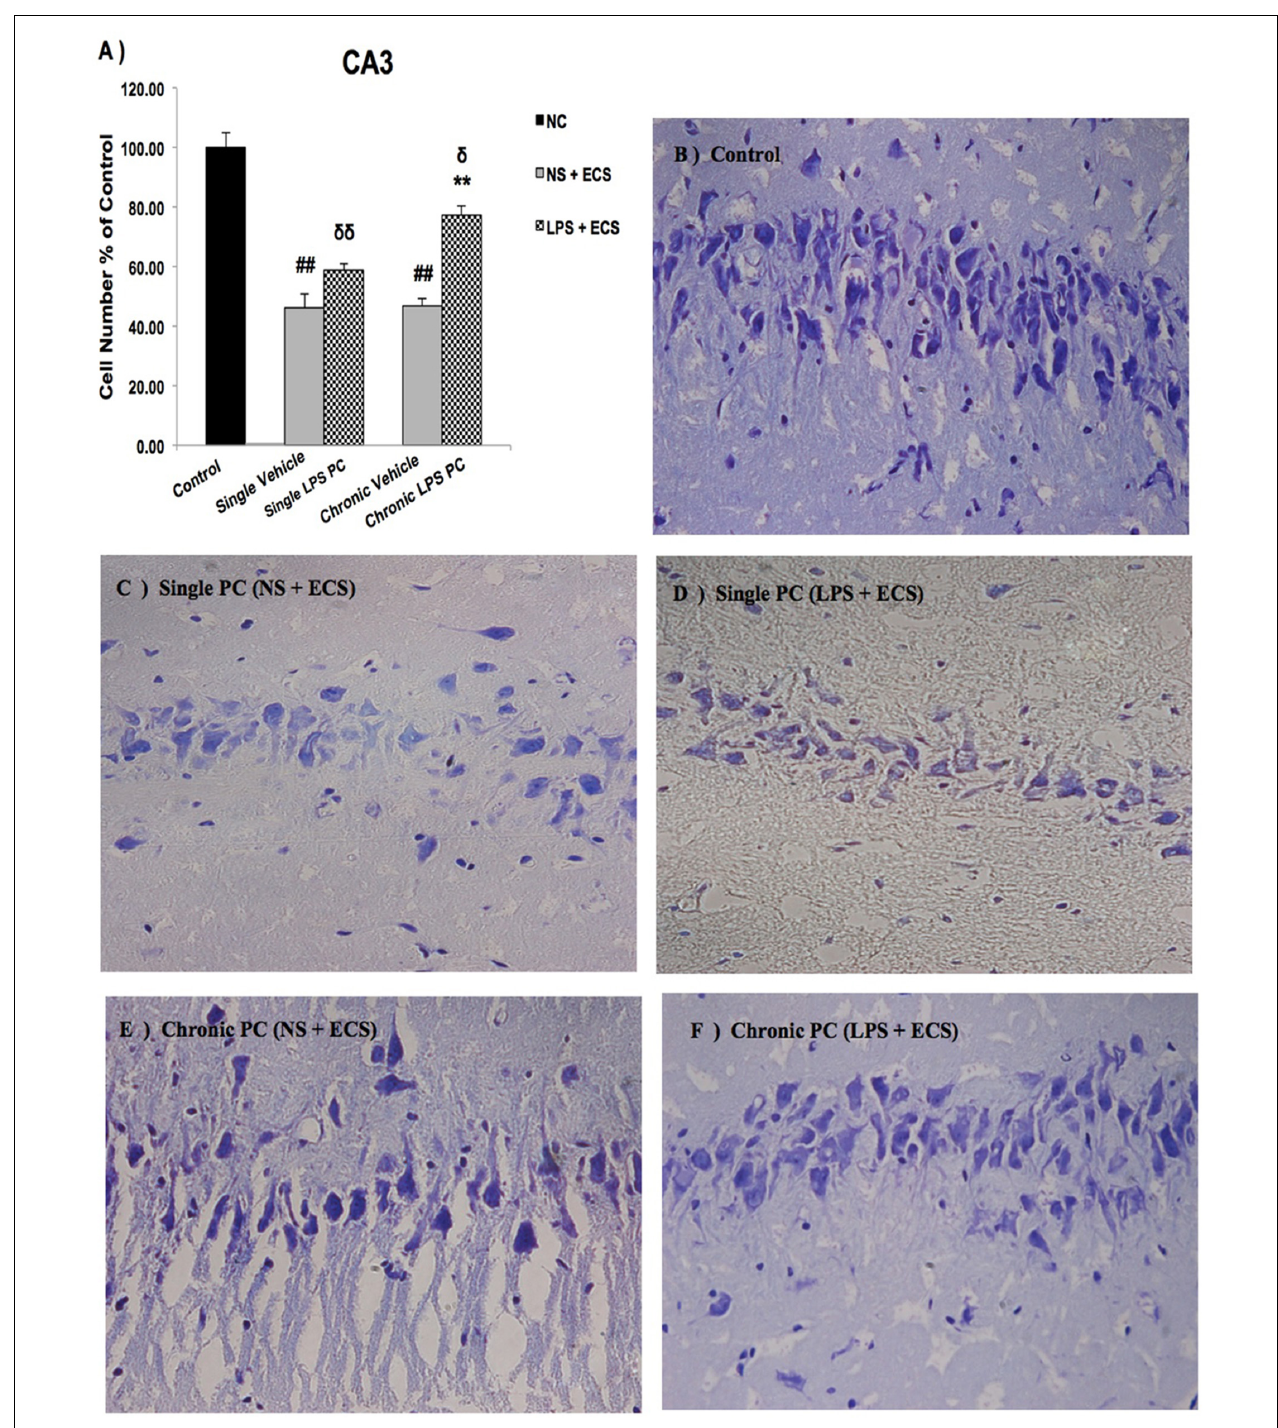
FIGURE 4 | Photomicrographs of Nissl-stained CA3 sub-region of rat brain hippocampus in the ECS model of epilepsy ( n = 3). (A) Effect of single low dose and chronic ultra-low dose of LPS preconditioning on the number of CA3 cells, (B) control, (C) vehicle (single NS), (D) single LPS preconditioned groups, (E) vehicle (chronic NS), and (F) chronic LPS preconditioned groups in the ECS model. Scale bars are equal to 50 µ m. Asterisk ( ∗ ) denotes a significant difference between the preconditioned groups and vehicle groups. Delta ( δ ) denotes a significant difference between the preconditioned groups and control groups. Hash (#) denotes a significant difference between the vehicle groups and control groups. Statistical analysis has been done according to the one-way ANOVA with significance levels of ∗∗ ρ < 0.01; δ ρ < 0.05, δδ ρ < 0.01; and ## ρ < 0.01. Data are shown as mean% ± SEM of three animals ( n = 3), which expressed as the cell number percentage with respect to the control. ECS, electroconvulsive shock; NS, normal saline; LPS, lipopolysaccharide; PC, preconditioning; NC, no current was passed through the electrodes.